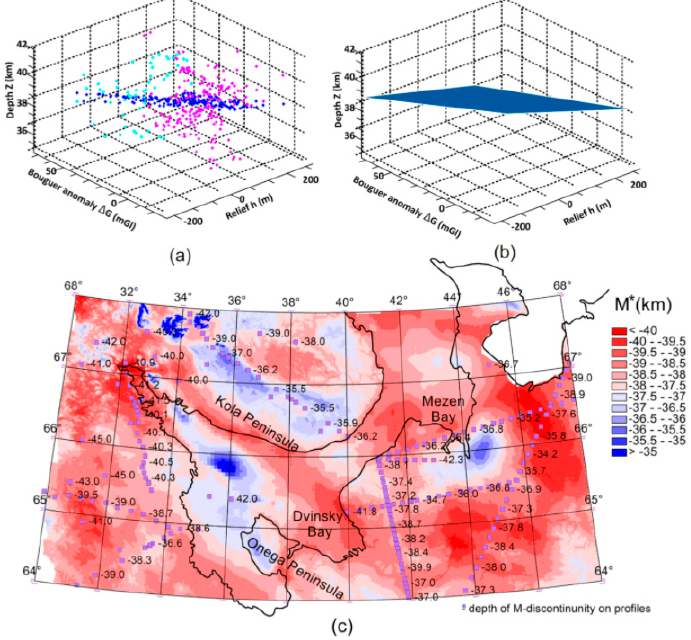
Figure 6. Regression model in the deep seismic sections relating the depth of occurrence of M-discontinuity (Z, km) to Bouger anomaly ( ∆ G, mGl) and the topographic mark (h, m). ( a ) Reference data related to land and sea are shown in pink and sky-blue, respectively, and model results in blue; ( b ) position of the regression plane of the M-discontinuity in the coordinate system a; ( c ) map of the depths of occurrence of M-discontinuity based on Equation (2) and combined with data on deep seismic sounding (DSS) profiles. The absence of the sedimentary layer in a part of the White Sea (Figure 5a) may be caused by the uplift of these parts associated with the Fennoscandian shield. A thick sedimentary layer in the White Sea Funnel hinders deep water exchange in the White and Barents Seas and is one of the causes of the low salinity of the White Sea, about 26 ppm, and associated ecological and biological effects. The uplifts of the underlying surface of the “granite-metamorphic layer” fall on the structures of the Karelian and Kola megablocks, the Zimny Bereg Uplift, and the Onega peninsula (Figure 5b). In this connection, the Zimny Bereg Uplift and the Onega Peninsula can be considered as the continuation of the structures of the Tersk coast of the White Sea and the Karelian megablock, respectively. An example of the connection of the layer’s form with geological processes is provided by the depression of the M-discontinuity, identified in the White Sea Throat. The results of modelling generalized empirically show that there is a subvertical crustal structure near the Zimny and Tersk Shores, the White Sea Throat, and the White Sea Funnel associated with kimberlite magmatism. Diatremes, sills, and explosion pipes are located in some parts of the Archean-Early Proterozoic crust with a mosaic type of geophysical anomaly and are confined to linear tectonic zones [12]. The depression of the M-discontinuity in the White Sea Throat, reflecting earth crust–mantle interaction, is a criterion for diamond potential [38]. The similarity of its local extrema (Figure 5d) indicates the interpenetration, mixing, and transformation of deep-seated matter in the conjugation